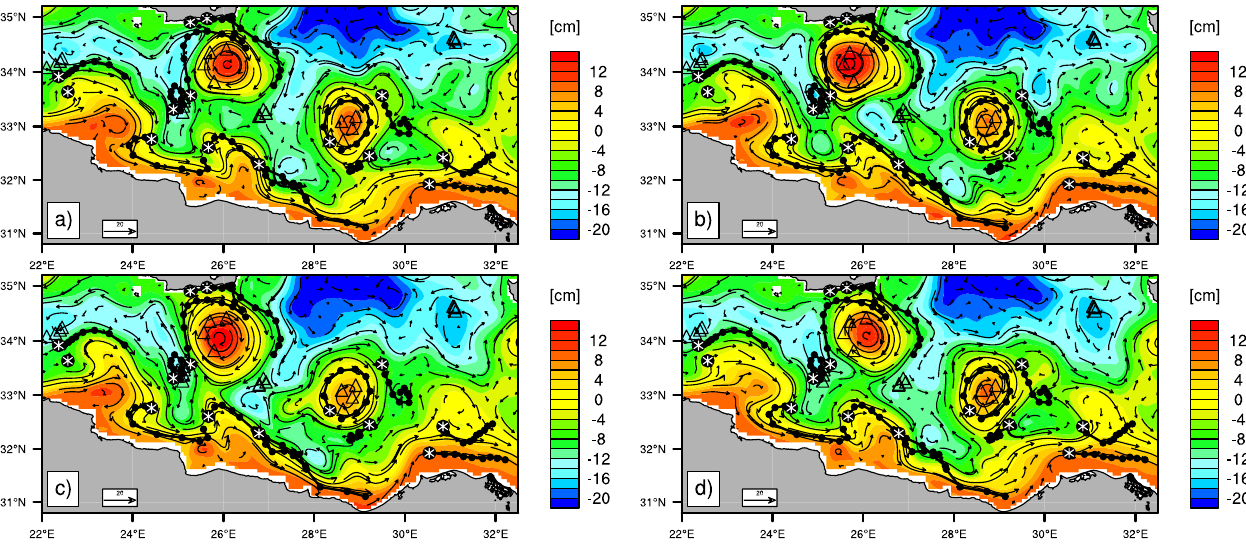
Fig. 4. Sea-surface height fields (cm) on 22 December 2005 with superimposed velocity vector fields at 15m depth from the (a) CTRL, (b) SURF, (c) SURF2, and (d) ARGO experiments. The daily observed surface drifter positions during 13–22 December are indicated by the black dots with start positions in white. The Argo float positions are measured every 5 days and marked for the 1–22 December period by